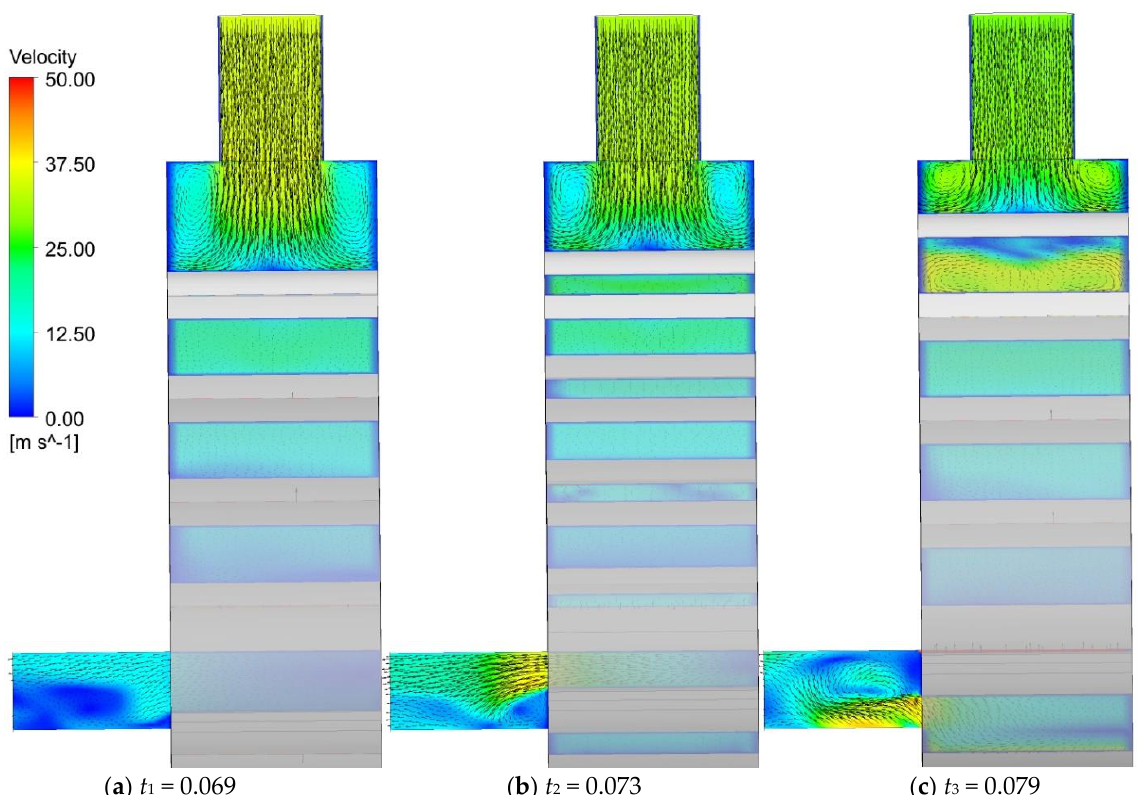
Energies 2021 , 14 , x FOR PEER REVIEW 12 of 29